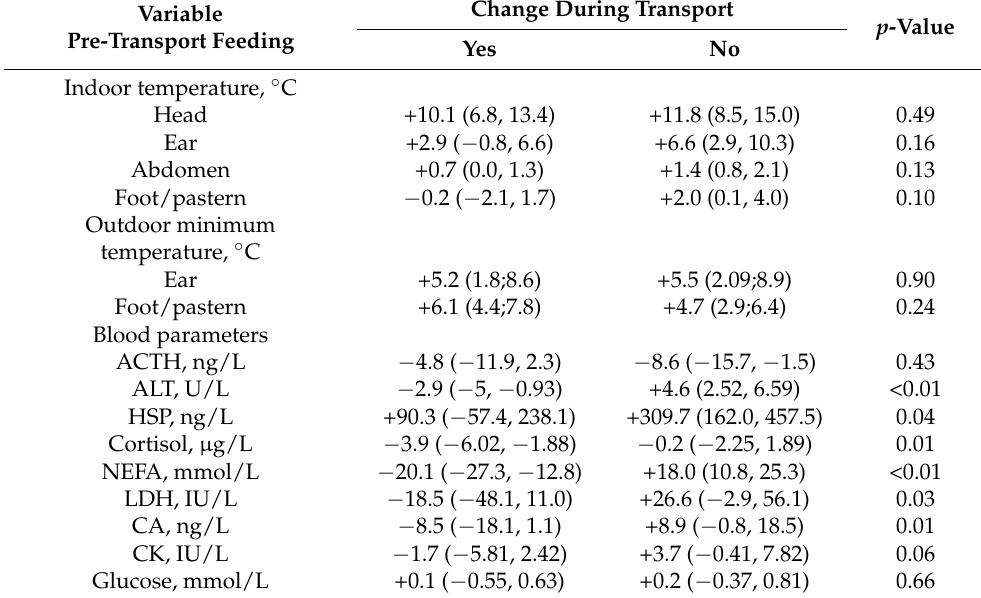
Table 3. Changes in temperatures, infrared temperature images and blood parameters during transport (values at arrival minus values at departure) of sheep (n = 2 × 10) in experiment 3. Mean changes were adjusted for departure values and are presented with 95% confidence intervals. p -values indicate the statistical significance of treatment group effects on the adjusted